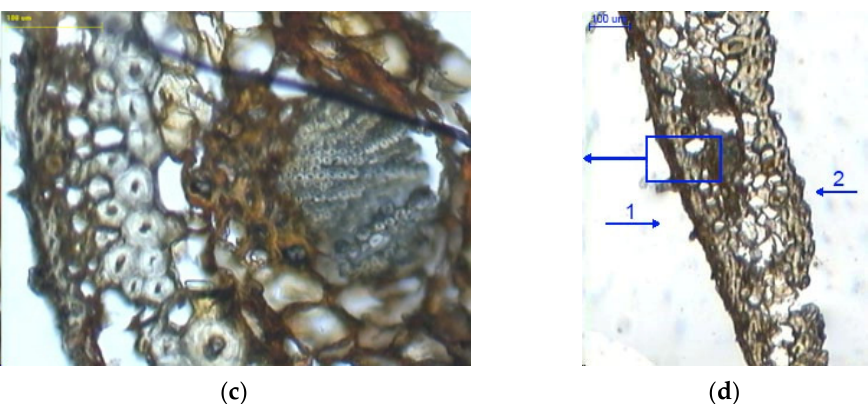
Figure 7. Cross-sections of scales with a moisture content of 20%: ( a ) outer epidermal cell layer (100×); ( b ) scale with visible cell layers on the inner side (100×); ( c ) cell layer in bundles between large cells (100×); ( d ) scale with visible cell layers in the marginal region (40×), 1–outer side of the scale, and 2–inner side of the scale.